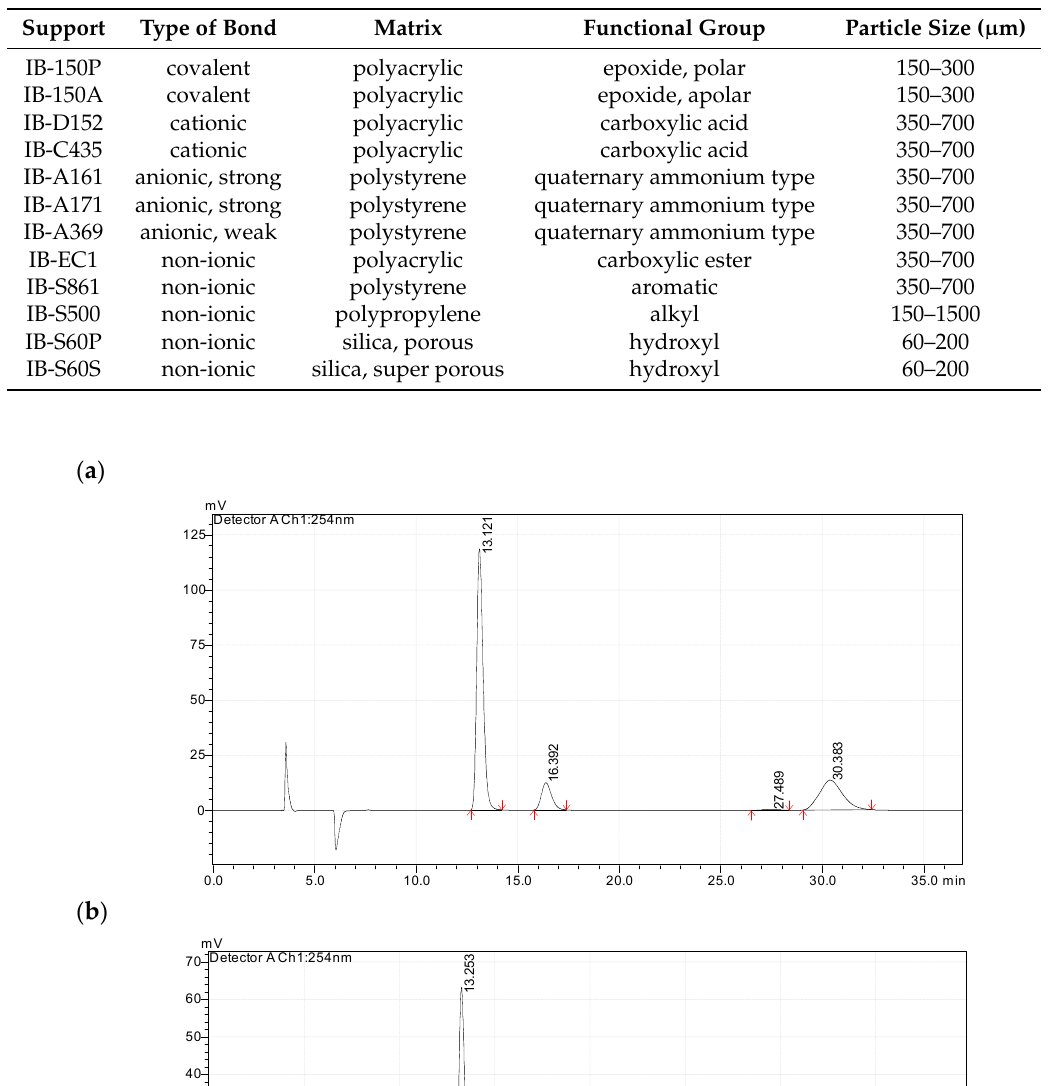
Table 1. Properties of the carriers used (data received from the supplier, ChiralVision).